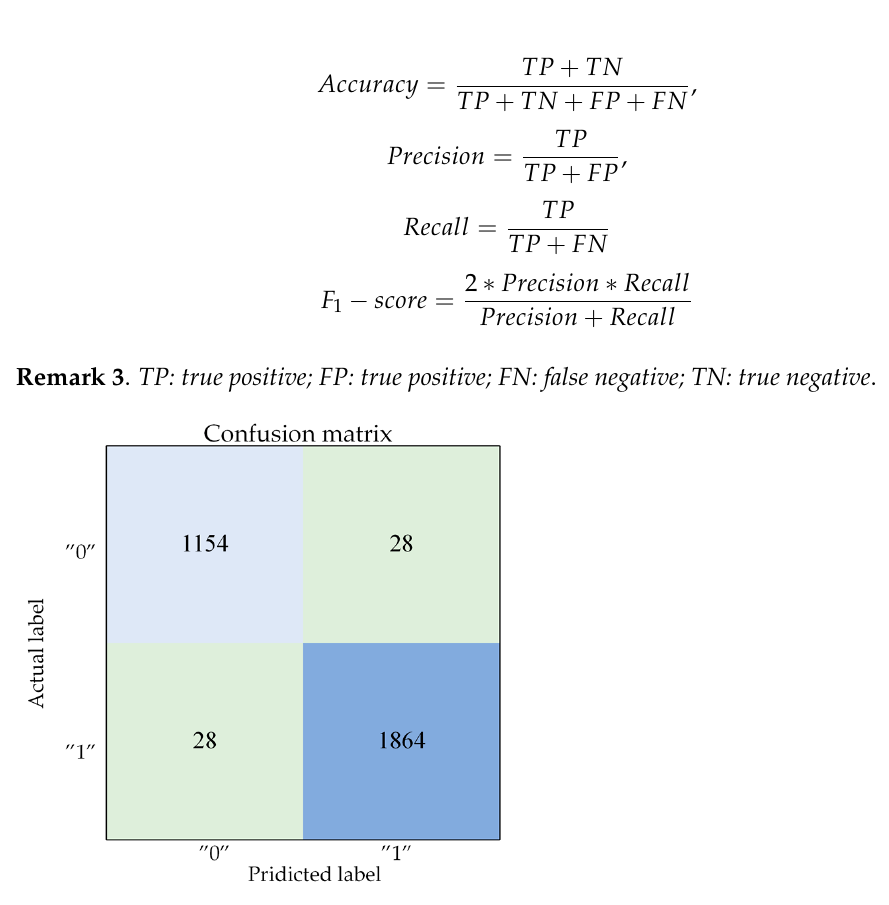
Table 4. Performance evaluation of seven classifier models. Accuracy 76.15% Figure 8. Accuracy of seven classifier models. The ROC curves and the corresponding AUC values for the seven classifier models are shown in Figure 9.